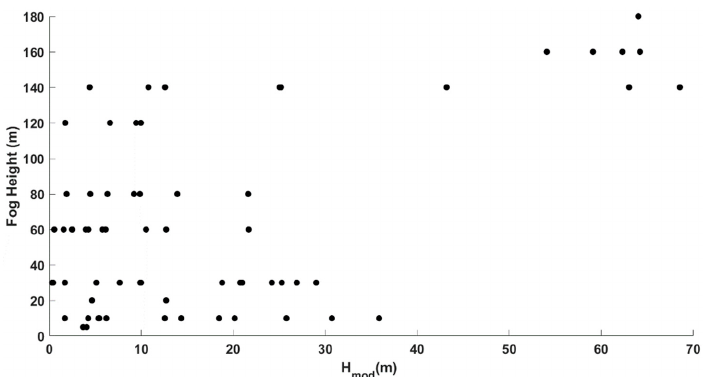
Figure 4. Scatterplots of observations of fog thickness against the estimations with Equation